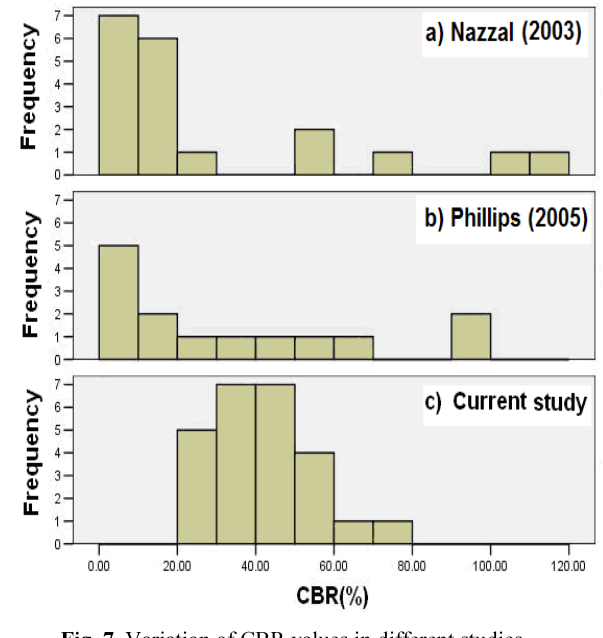
Fig. 7. Variation of CBR values in different studies